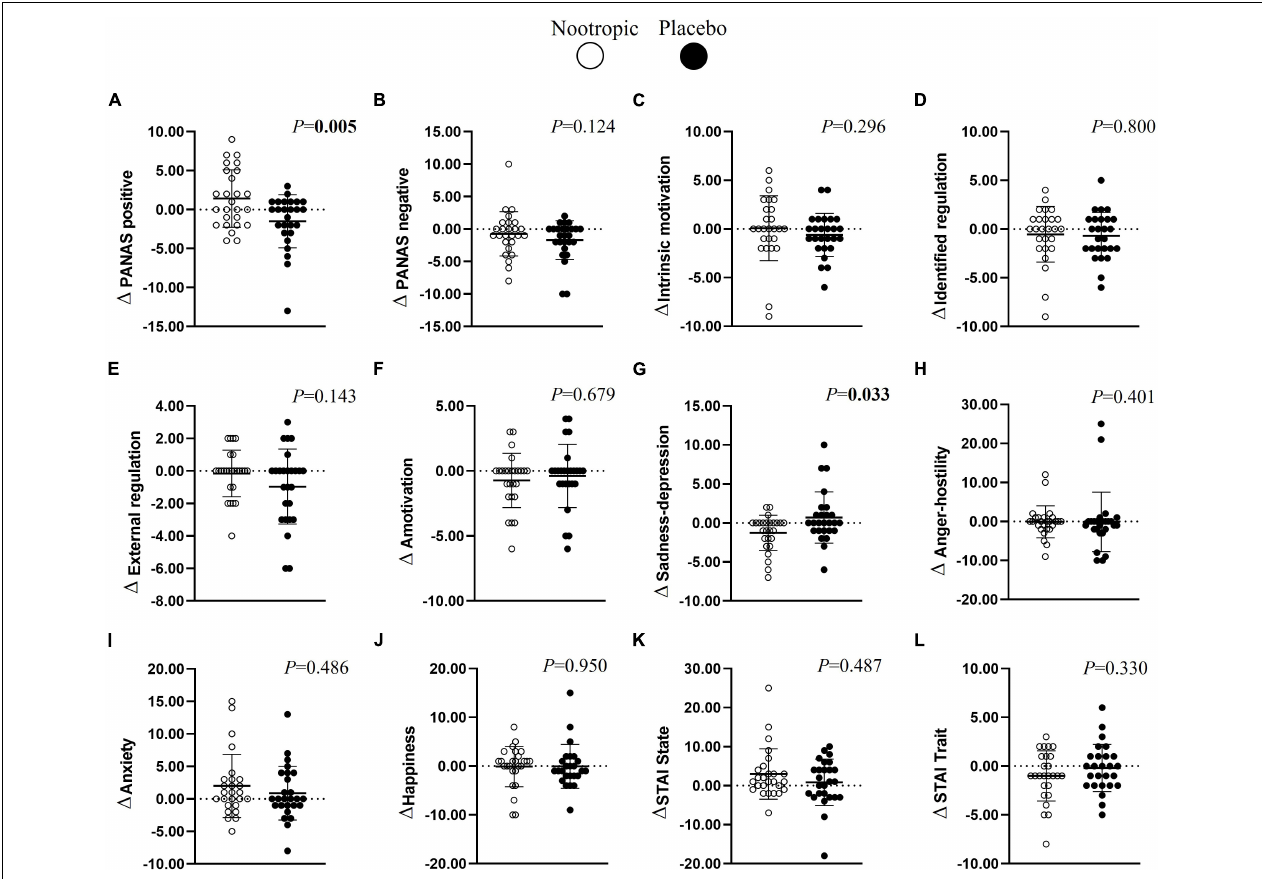
FIGURE 4 | Effects of a nootropic ergogenic aid (denoted as white circles) in comparison with a placebo (denoted as black circles) on emotional status differences ( (cid:49) = after beverage − before beverage) between before and after the performance of the cognitive test by the participants. Emotional status include positive (A) and negative (B) emotions, intrinsic motivation (C) , identified (D) and external regulation (E) , amotivation (F) , sadness-depression (G) , anger-hostility (H) , anxiety (I) , happiness (J) , anxiety state (K) , and anxiety trati (L) . Circles represent individual values, whereas lines represent mean (i.e., central line) and standard deviation. Differences between nootropic and placebo were analyzed using the Wilcoxon test. Boldfaced values mean P < 0.05. PANAS, Positive and Negative Affect Schedule; STAI, State-Trait Anxiety